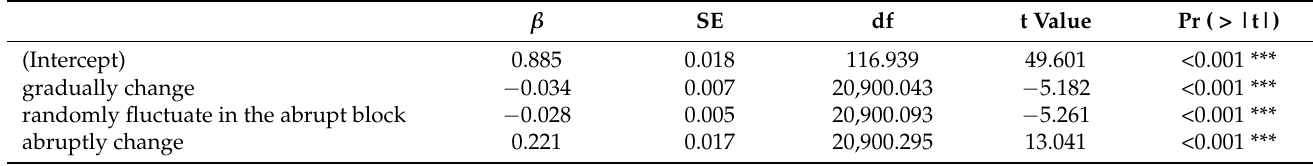
Table 7. The result of the mixed linear model of